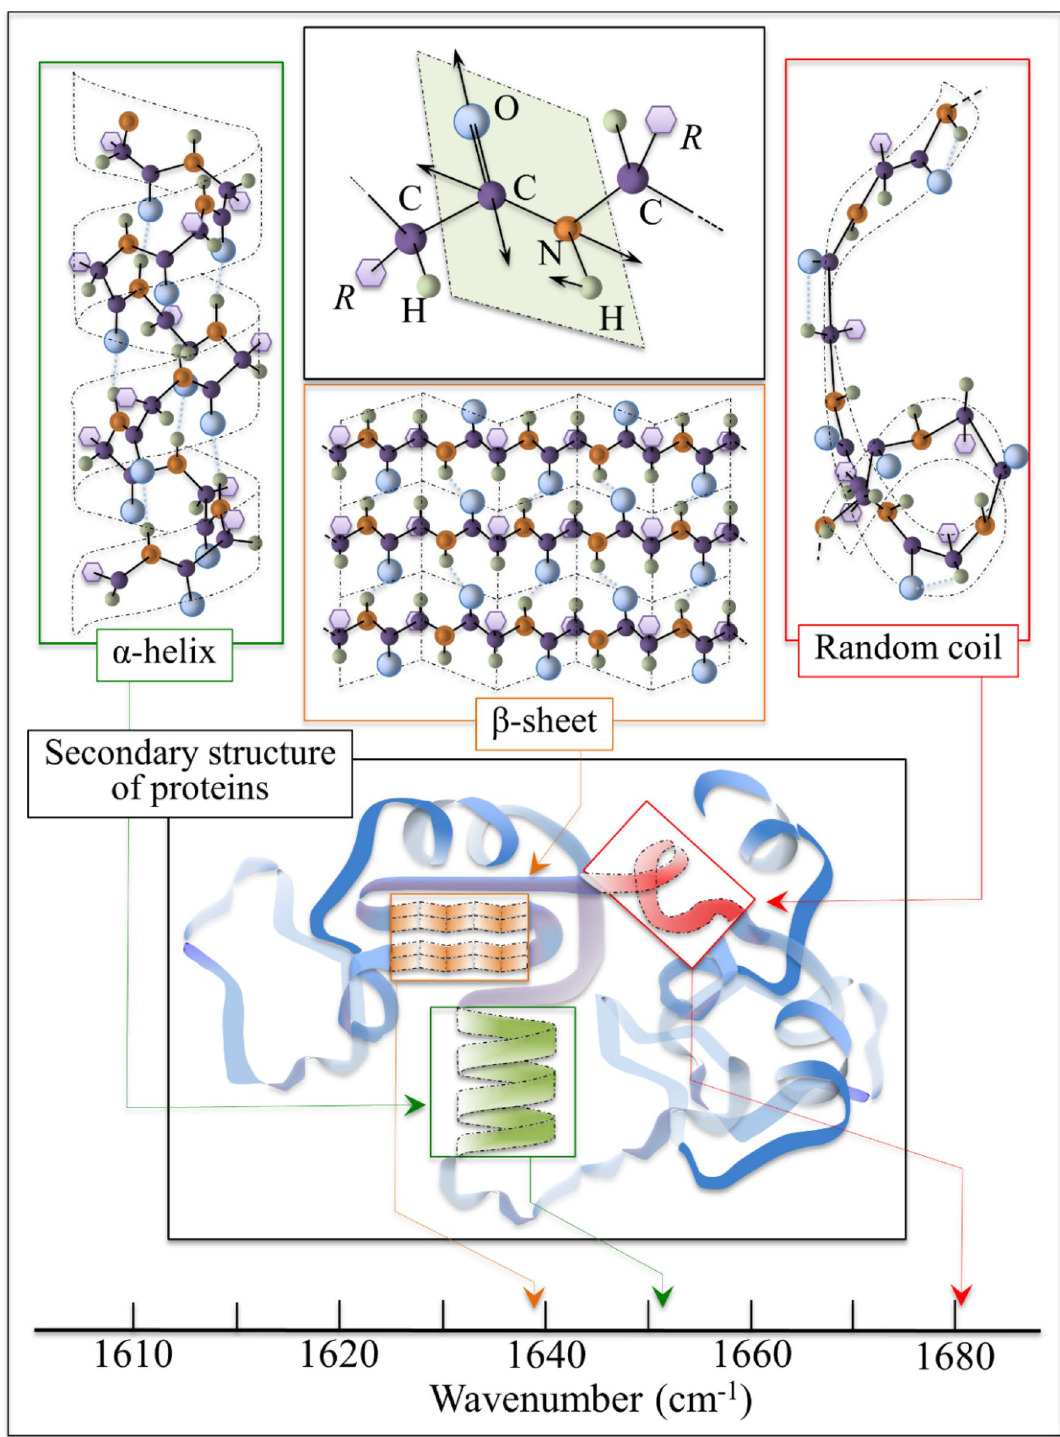
Figure 1. Explanatory schema of the different secondary structures involved with the spectroscopic measurement of human age based on the protein folding mechanism. Three kinds of protein mesostructures (shown in Table S2) are detected by Raman spectroscopy. Our previous study 28 suggested that the rate of random coiled disordered protein structures (Raman signal seen at 1681 cm −1 ) becoming α-helix structures (Raman signal at 1652 cm −1 ) was age